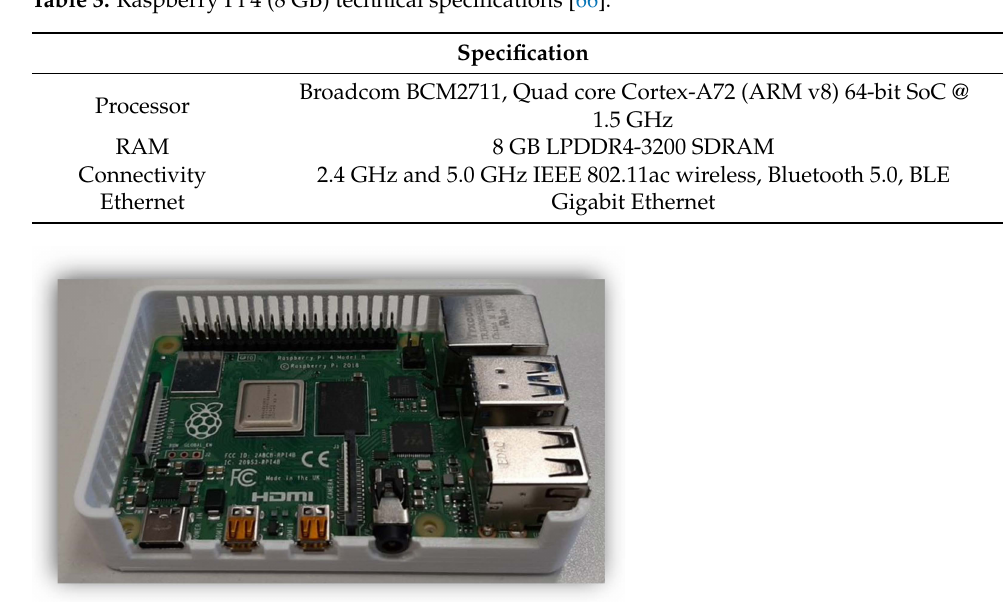
Figure 2. Raspberry Pi 4